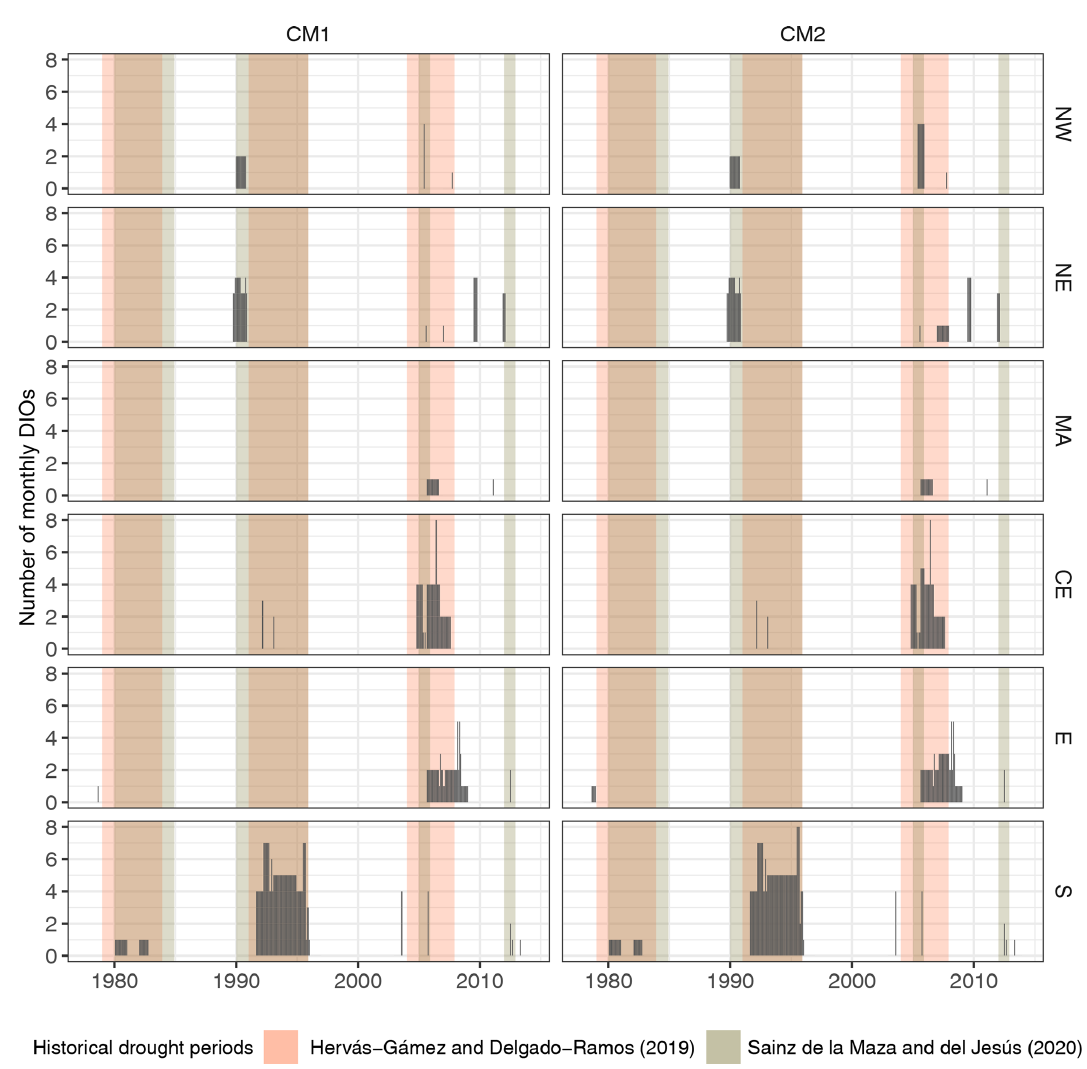
Figure 3. Monthly DIOs (bars) in each sub-region from 1975 to 2013, using the most censoring counting methods (CM1 and CM2). Important historical drought periods identified in other studies are